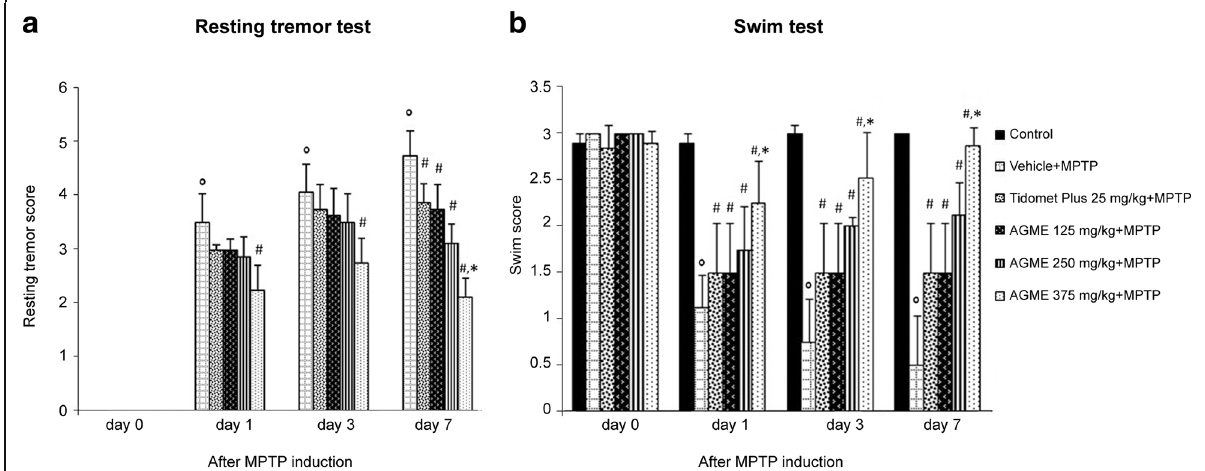
Fig. 4 Effect of AGME on resting tremor score ( a ) and swimming score ( b ) at 0, 1, 3, and 7 days after MPTP administration. Each data column represents the mean ± SD (n = 8/group, o - p < 0.01 compared with the control group; #- p < 0.05 compared with the vehicle-treated group; *- p < 0.05 compared with the Tidomet Plus-treated